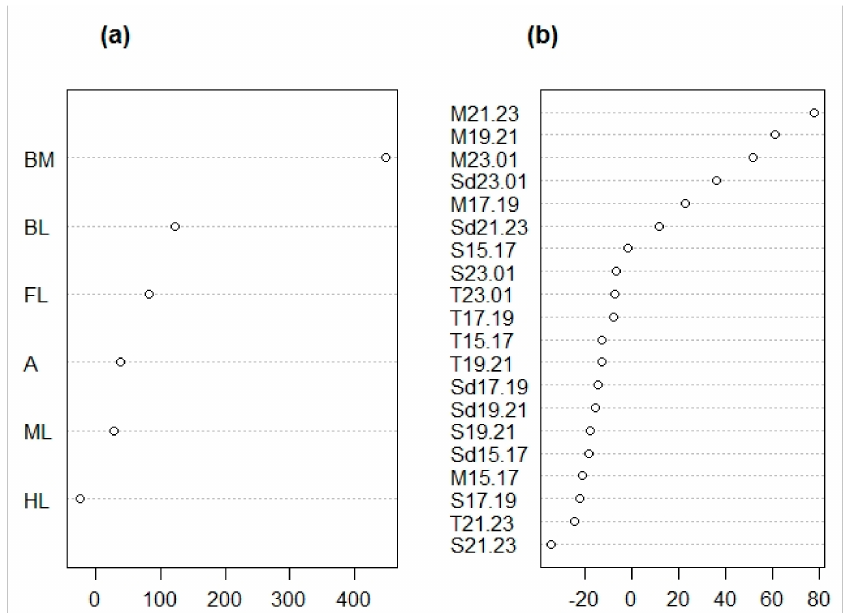
Figure 6. Ranking of mean decrease in accuracy (MDA) scores after a random forest analysis comparing morphological ( a ) and chemical ( b ) traits of parthenogenetic vs. sexual females of Clitarchus hookeri . (a) A statistical classification indicates the best morphological trait to distinguish sexual and parthenogenetic females is the body mass ratio (BM). (b) No single chemical trait was identified as distinguishing the two reproductive modes. For details on the codes, see Table 1.